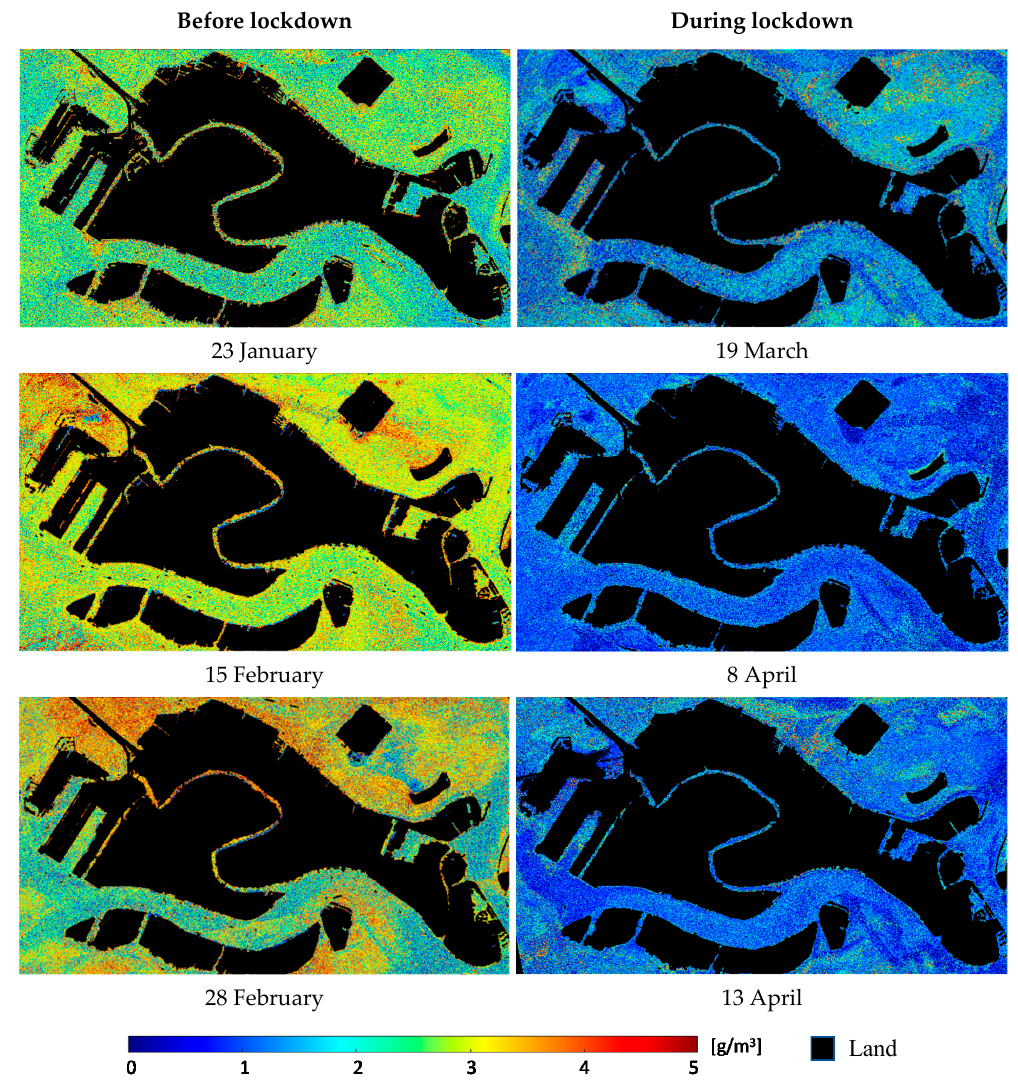
Figure 2. Multitemporal maps of concentration of total suspended matter (TSM) before and during the COVID-19 lockdown.